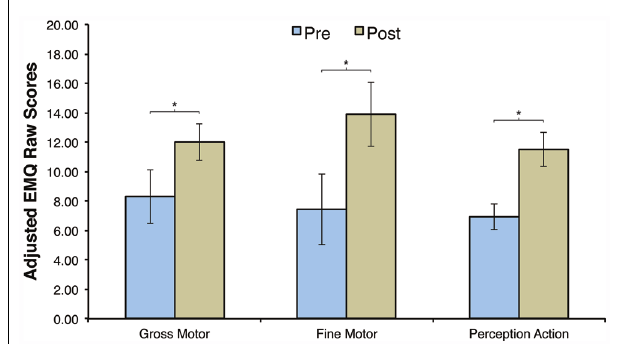
FIGURE 4 |Adjusted Early Motor Questionnaire (EMQ) raw scores before (Pre) and after (Post) training for the high risk active training group. Error bars are SEM, * p < 0.05.